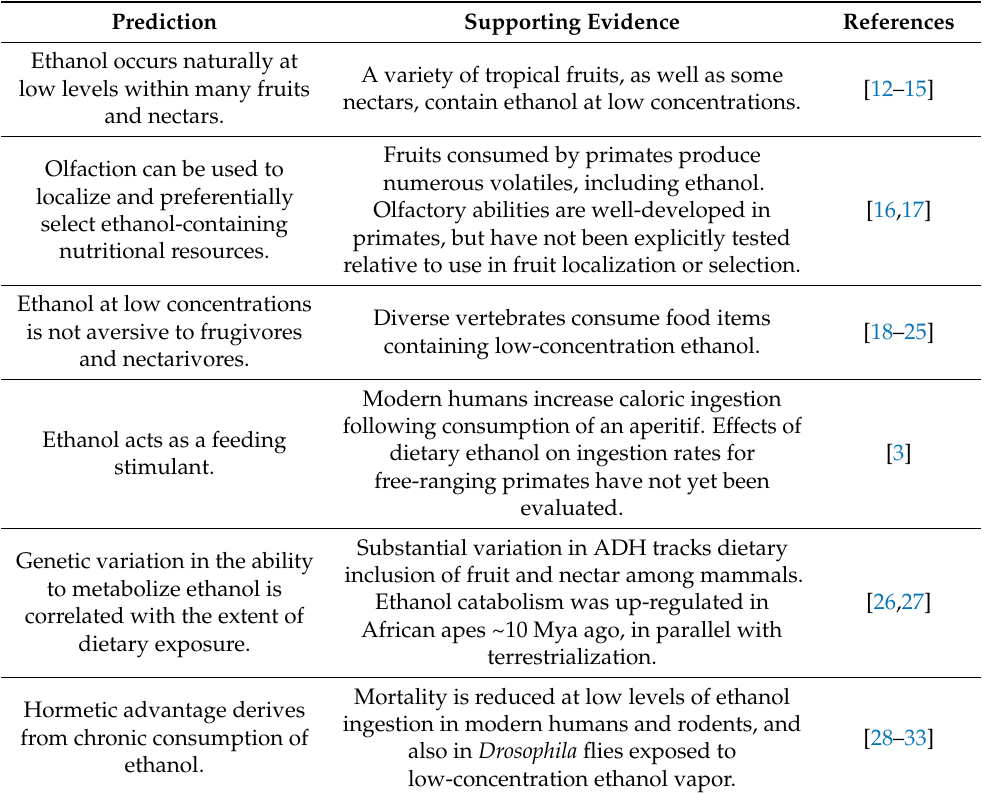
Table 1. Predictions of the “drunken monkey” hypothesis and supporting empirical